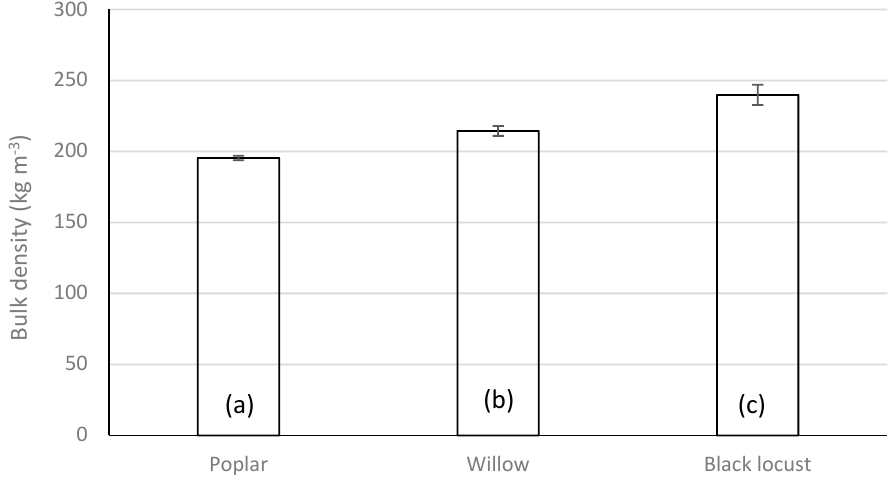
Figure 3. Means values of bulk density (kg·m − 3 ). Mean values with a different letter are significantly different at p < 0.05.